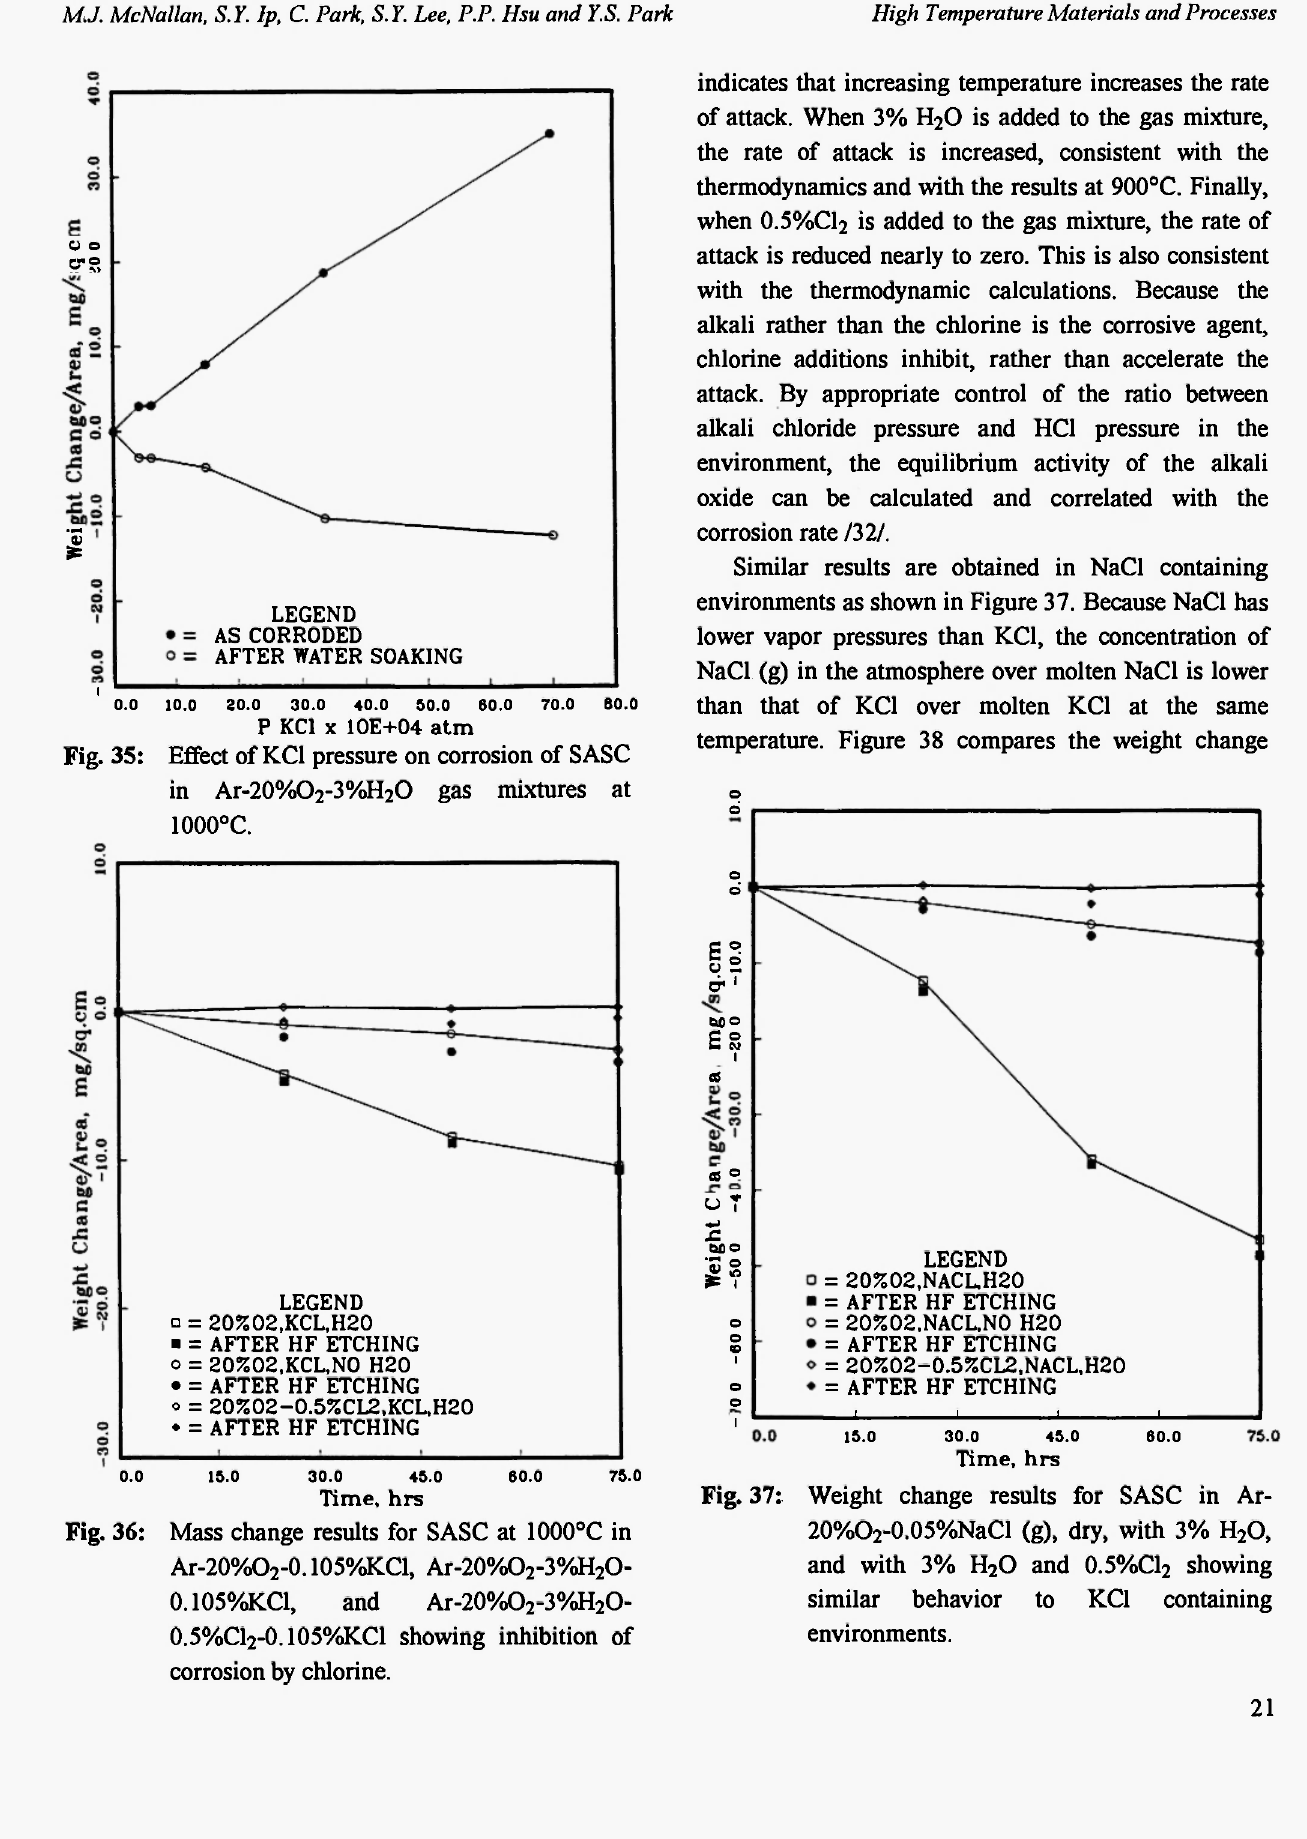
Fig. 36: Mass change results for SASC at 1000°C in Ar-20%0 -0.105%KC1, Ar-20%0 2 0.105%KC1, and Ar-20%0 0.5%C1 -0.105%KC1 showing inhibition of 2 corrosion by chlorine.